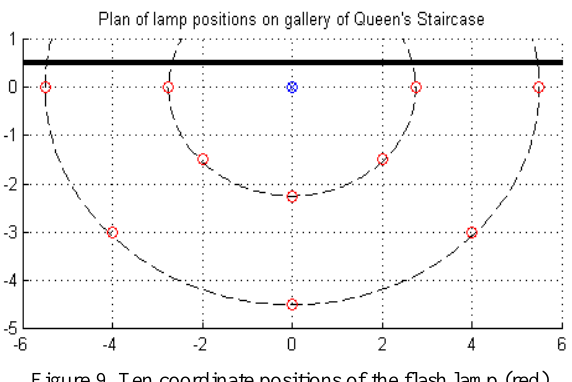
Figure 9. Ten coordinate positions of the flash lamp (red) relative to the camera (blue). All units are in metres. The successive positions of the flash light on its mast over the floor area of the landing of the Queen’s Staircase were plotted on Cartesian coordinates, with the camera position at the origin (Fig. 9). They fall approximately onto two concentric ellipses. The lamp was at a constant distance of 62 cm below the ceiling. From these dimensions the cosines with respect to the three axes were calculated (Table 2). The angle of incidence of the light onto the surface was in the range 6°–8° for lamp positions in the outer ellipse and 13°–15° in the inner.